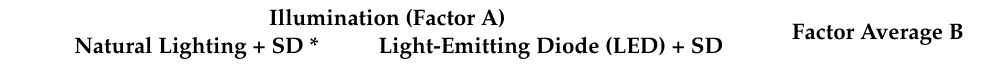
Table 1. Morphometric indicators of ex vitro development in highbush blueberry plants cv. Brigitta Blue on the 14th day of growing